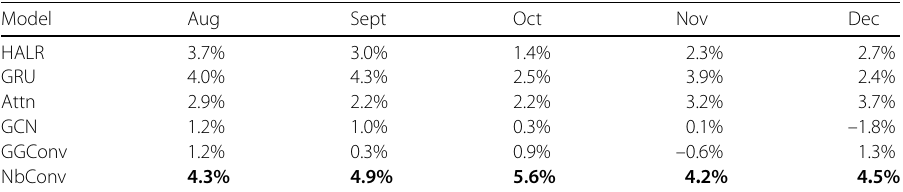
Table 7 Relative change in F1 score using C + M for property crime prediction in Chicago in each test month Model